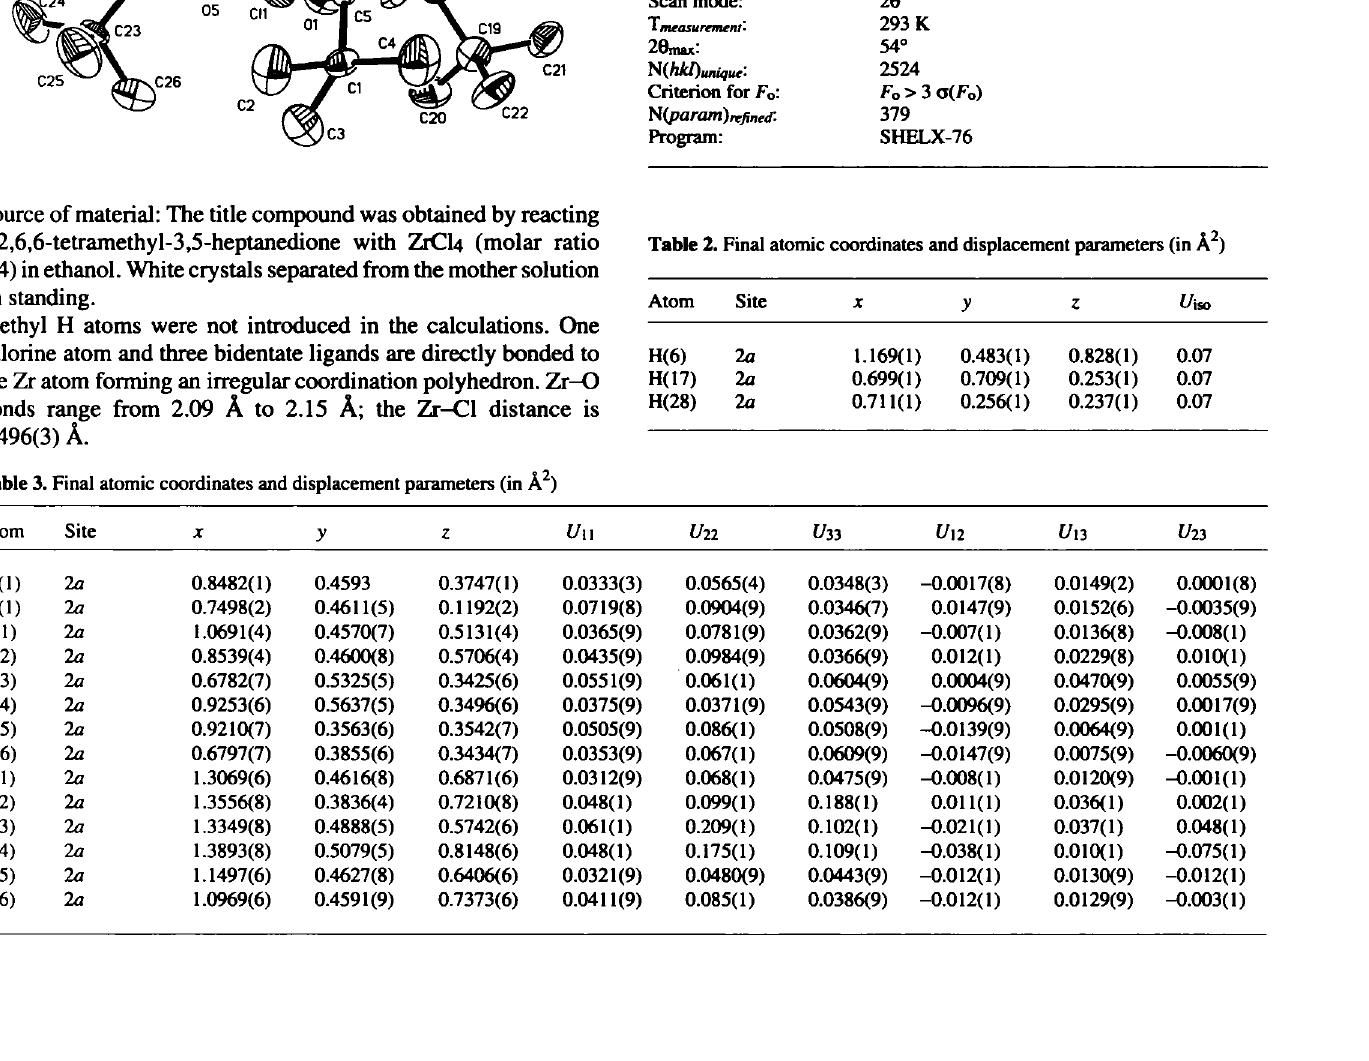
Table 1. Parameters used for the X-ray data collection